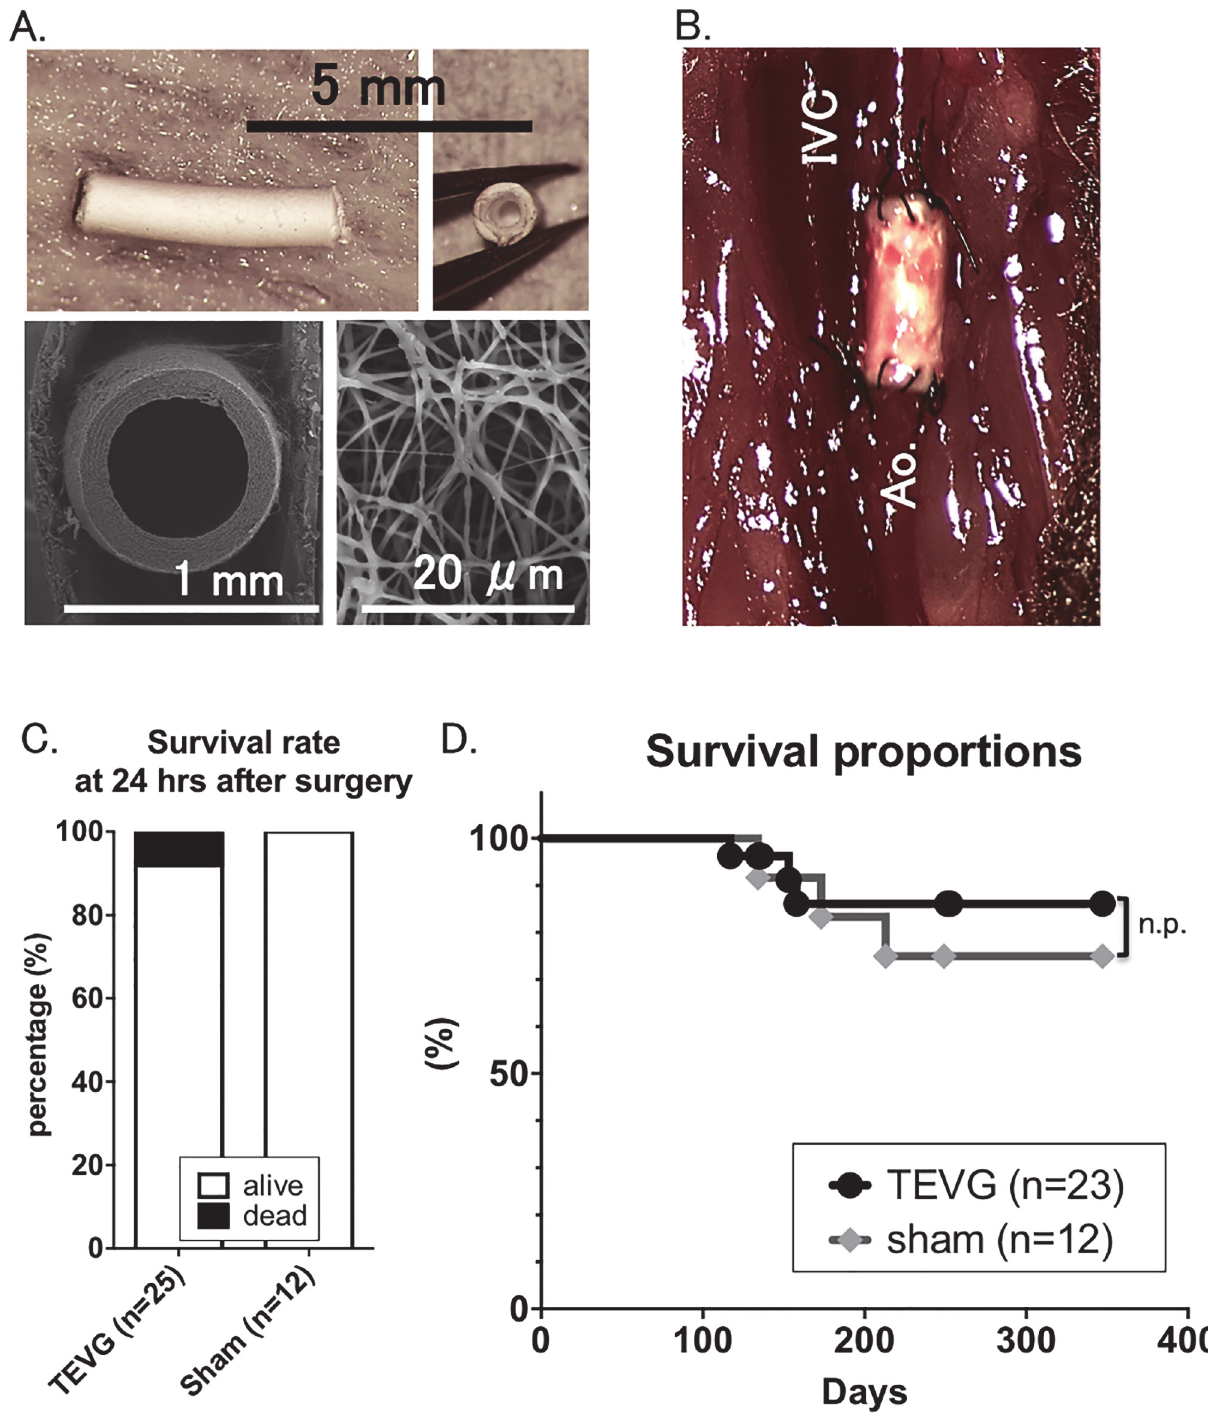
Fig 1. TEVG implantation was successful as indicated by a similar survival rate at 12-month post-operation in TEVG group to sham group. A. Structure of TEVG. Implanted TEVG was composed of biodegradable electrospun polylactic acid (PLA) nanofibers with a length of approximately 3mm and inner luminal diameter 500 – 600 μ m. Scanning electron microscopy demonstrates macro- and micro-arrangement of graft. B. TEVG after surgical implantation (IVC: inferior vena cava; Ao: aorta). C. Survival rate at 24 hours after surgery. 25 TEVGs were implanted in C17SCID/bg mice. 12 syngeneic mice underwent sham operations. > 90% of mice implanted with TEVG survived 24 hours after TEVG implantation. Peri-operative mortality was due to bleeding or thrombosis. D. Kaplan-Meier survival curve during the 12 months of experiment. Similar survival rate was seen between two groups over the course of 12